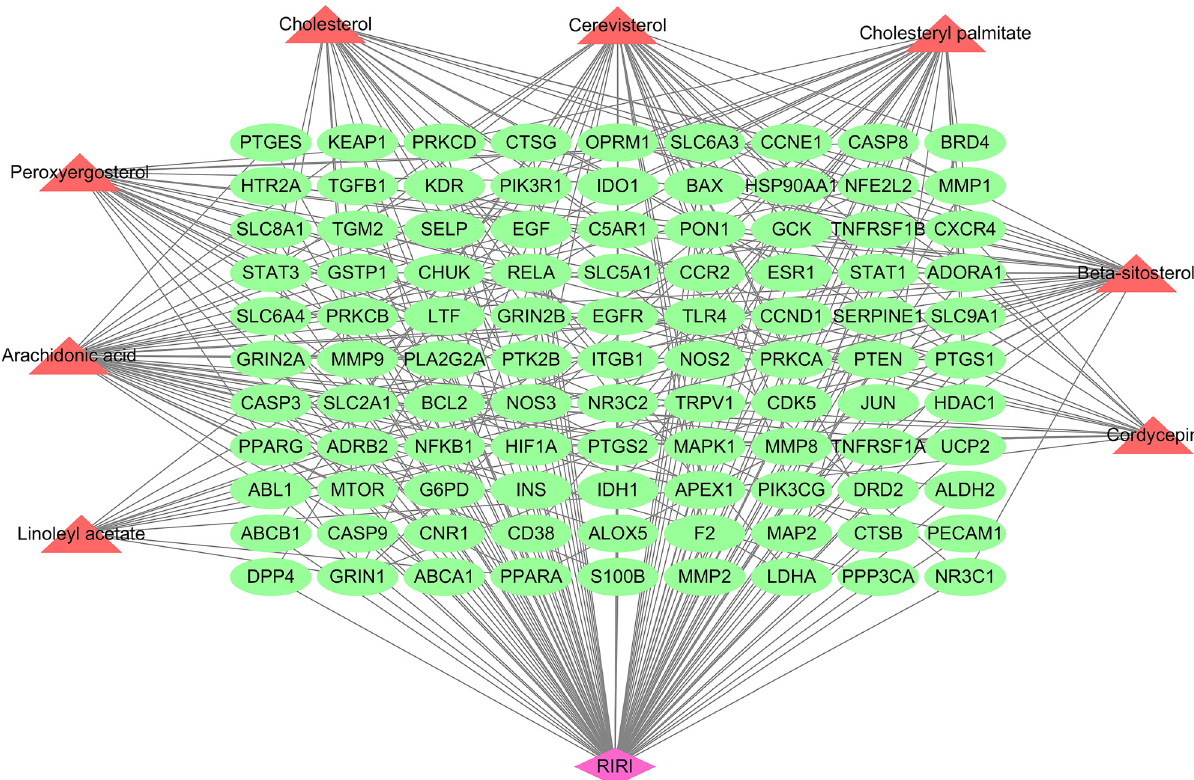
Figure 3: Active components – intersection targets – disease network of C. sinensis against RIRI. The 99 green ellipses in the middle represent intersection targets. The surrounding triangle nodes mean the active components. The bottom diamond represents RIRI. The interactions between the components, disease, and their targets were connected by edges.